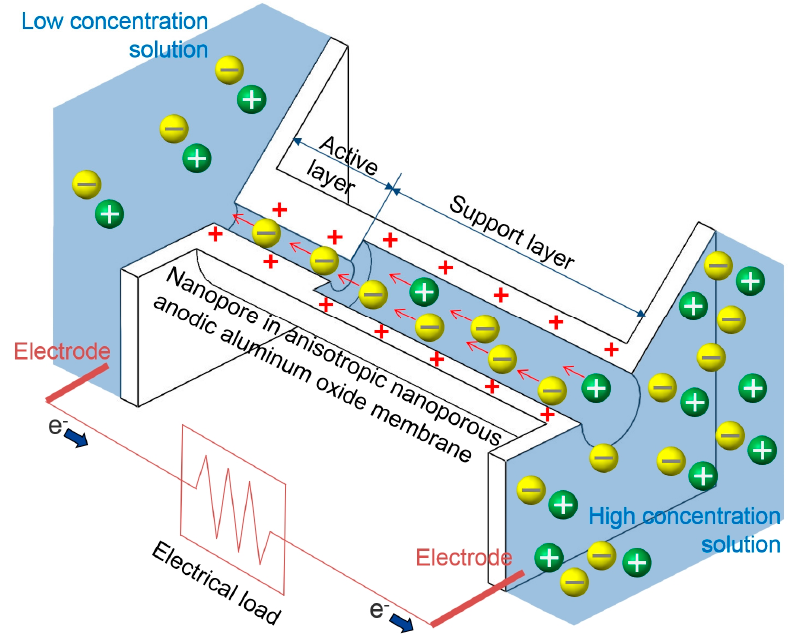
Figure 1. Reverse electrodialysis in an anisotropic nanoporous anodic aluminum oxide membrane.